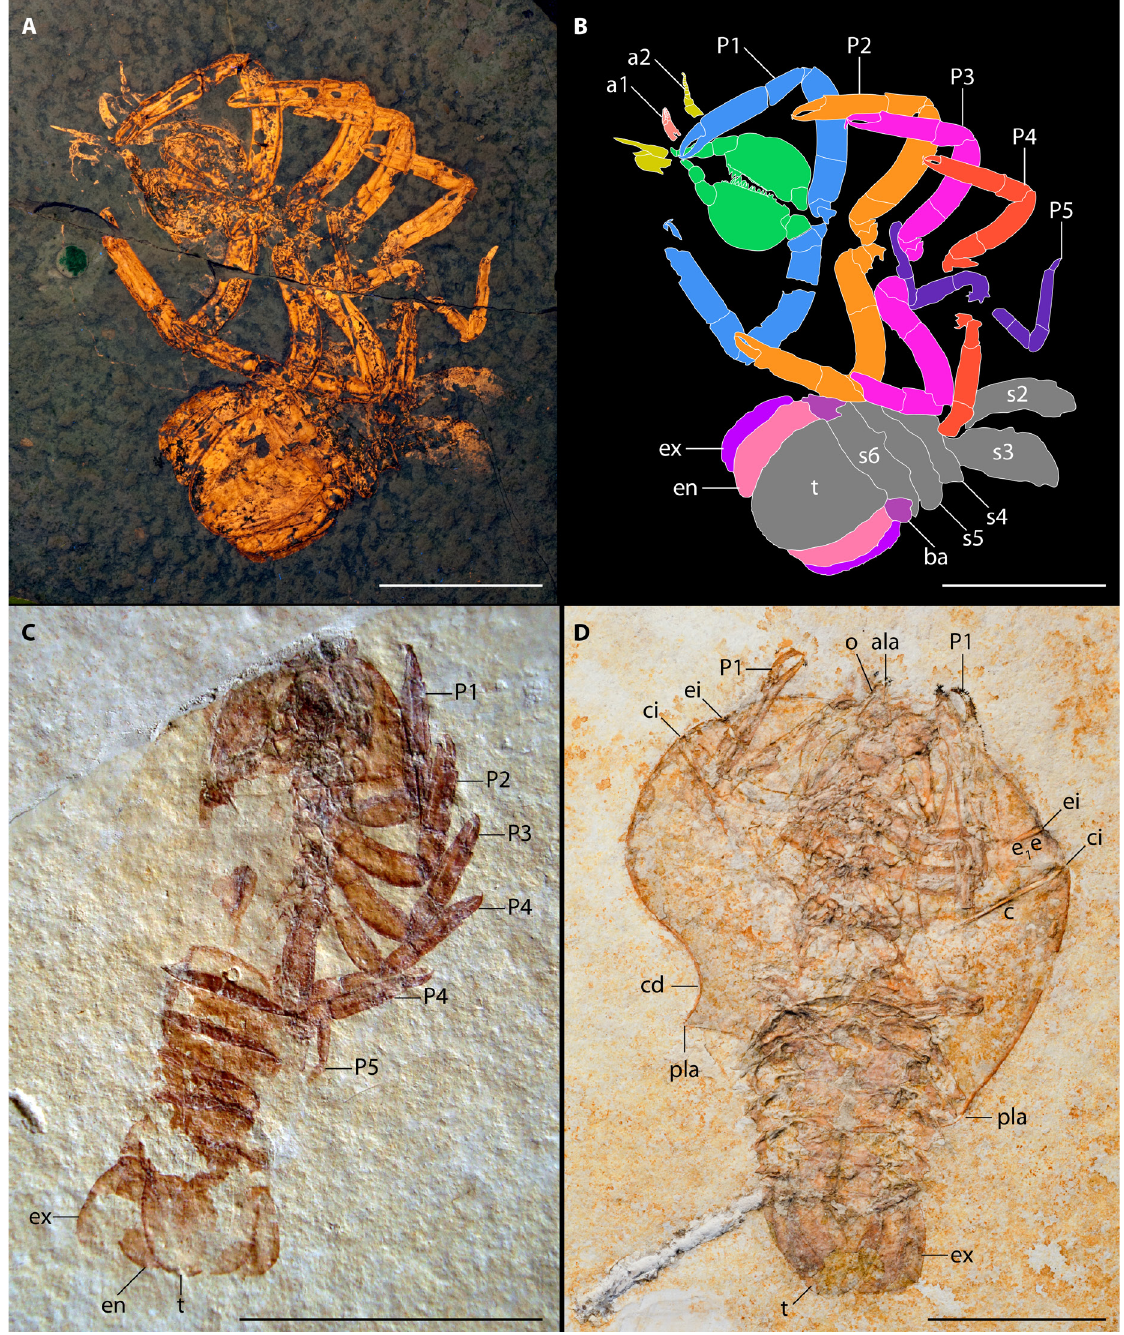
Fig. 4. Rogeryon oppeli (Woodward, 1866) gen. et comb. nov. from the Upper Jurassic (Tithonian) of Germany. A–B . Holotype NHMUK 44886 (Solnhofen area), dorsal view, UV-fluorescence (A) and interpretative line drawing (B). C . Specimen JMS 118 (Langenaltheim, Udo Resch coll.), dorsal view, natural light. D . Specimen SMNS 70102 (Solnhofen), dorsal view, cross-polarized light. Abbreviations: a1 = antennula; a2 = antenna; ala = anterolateral angle; ba = uropodal basipodite; c = postcervical groove; cd = carapace deformation; ci = postcervical incision; e e = cervical groove; en = uropodal 1 endopod; ei = cervical incision; ex = uropodal exopod; o = ocular incision; P1–P5 = pereiopods 1 to 5; pla = posterolateral angle; s1–s6 = pleonites 1 to 6; t = telson. Scale bars: 20 mm. Photographs: D. Audo, © NHMUK (A) and G. Schweigert